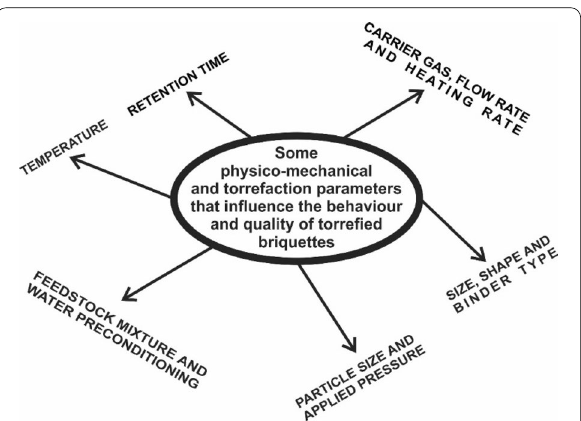
Fig. 5 Variables that influence the properties and quality of torrefied